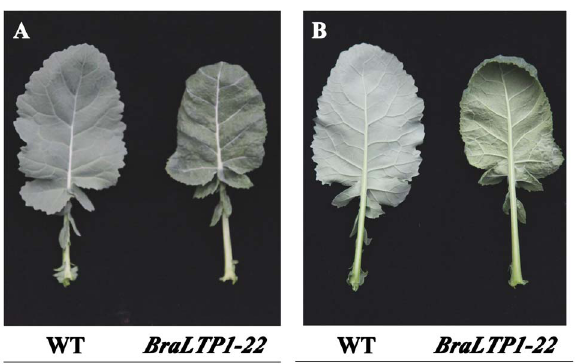
Figure 2. Leaf morphology of 35S::BraLTP1 overexpression line 22 ( BraLTP-22 ). The adaxial (A) and abaxial (underside) (B) morphology of a representative wild type (WT) leaf (left) and 35S::BnaLPT1 (right) are shown. WT leaves appear glaucous with a smooth surface compared to 35S::BnaLTP1 , which has an unglaucous, dark green and bumpy leaf surface with abaxial edge-curling.